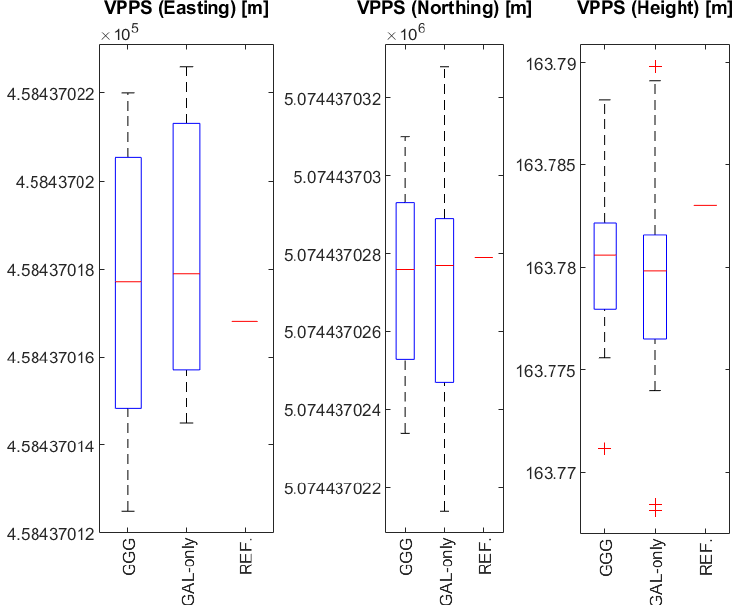
Figure 13. Box and whisker charts for Easting ( left ), Northing ( middle ), and Height ( right ) results obtained with VPPS (GGG), VPPS (GAL-only), and static GGGB daily solution (REF).